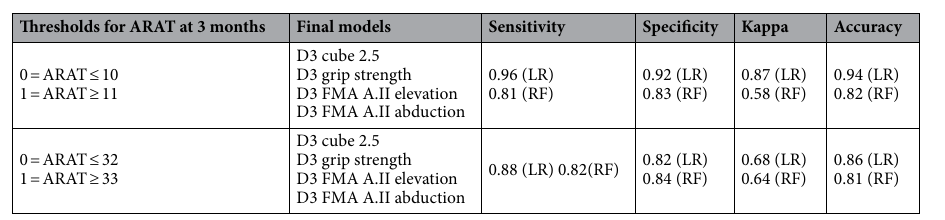
Table 2. Model performance determined by logistic regression (LR) analysis and Random Forest (RF) modeling for the two ARAT cut-offs between the poor, limited and good functional outcome. ARAT Action Research Arm Test, FMA Fugl-Meyer Assessment, LR logistic regression, RF random